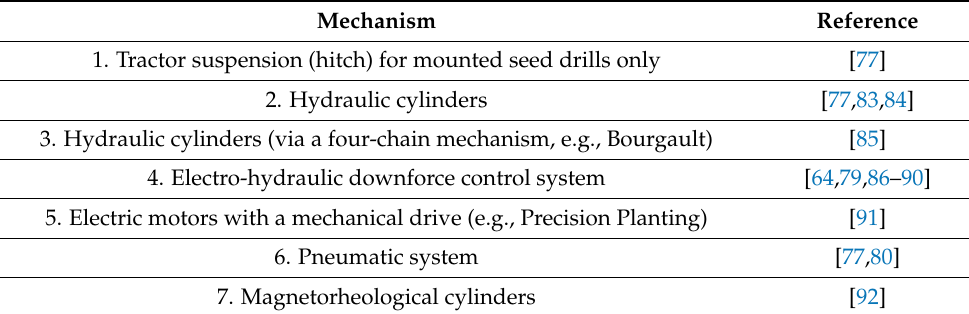
Table 3. Sowing depth adjustment